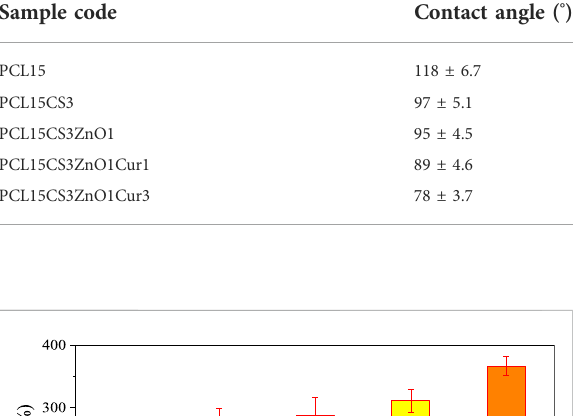
FIGURE 8 WVTR of the electrospun